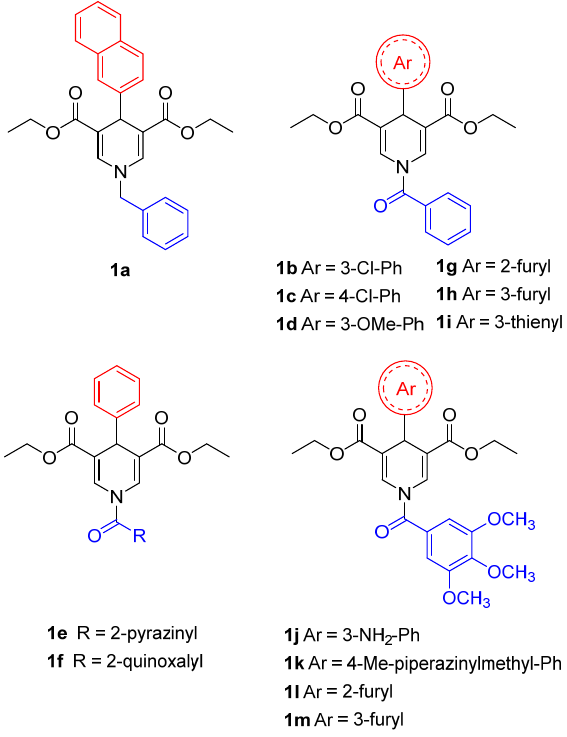
Figure 5. Structures of compounds 1a – 1m